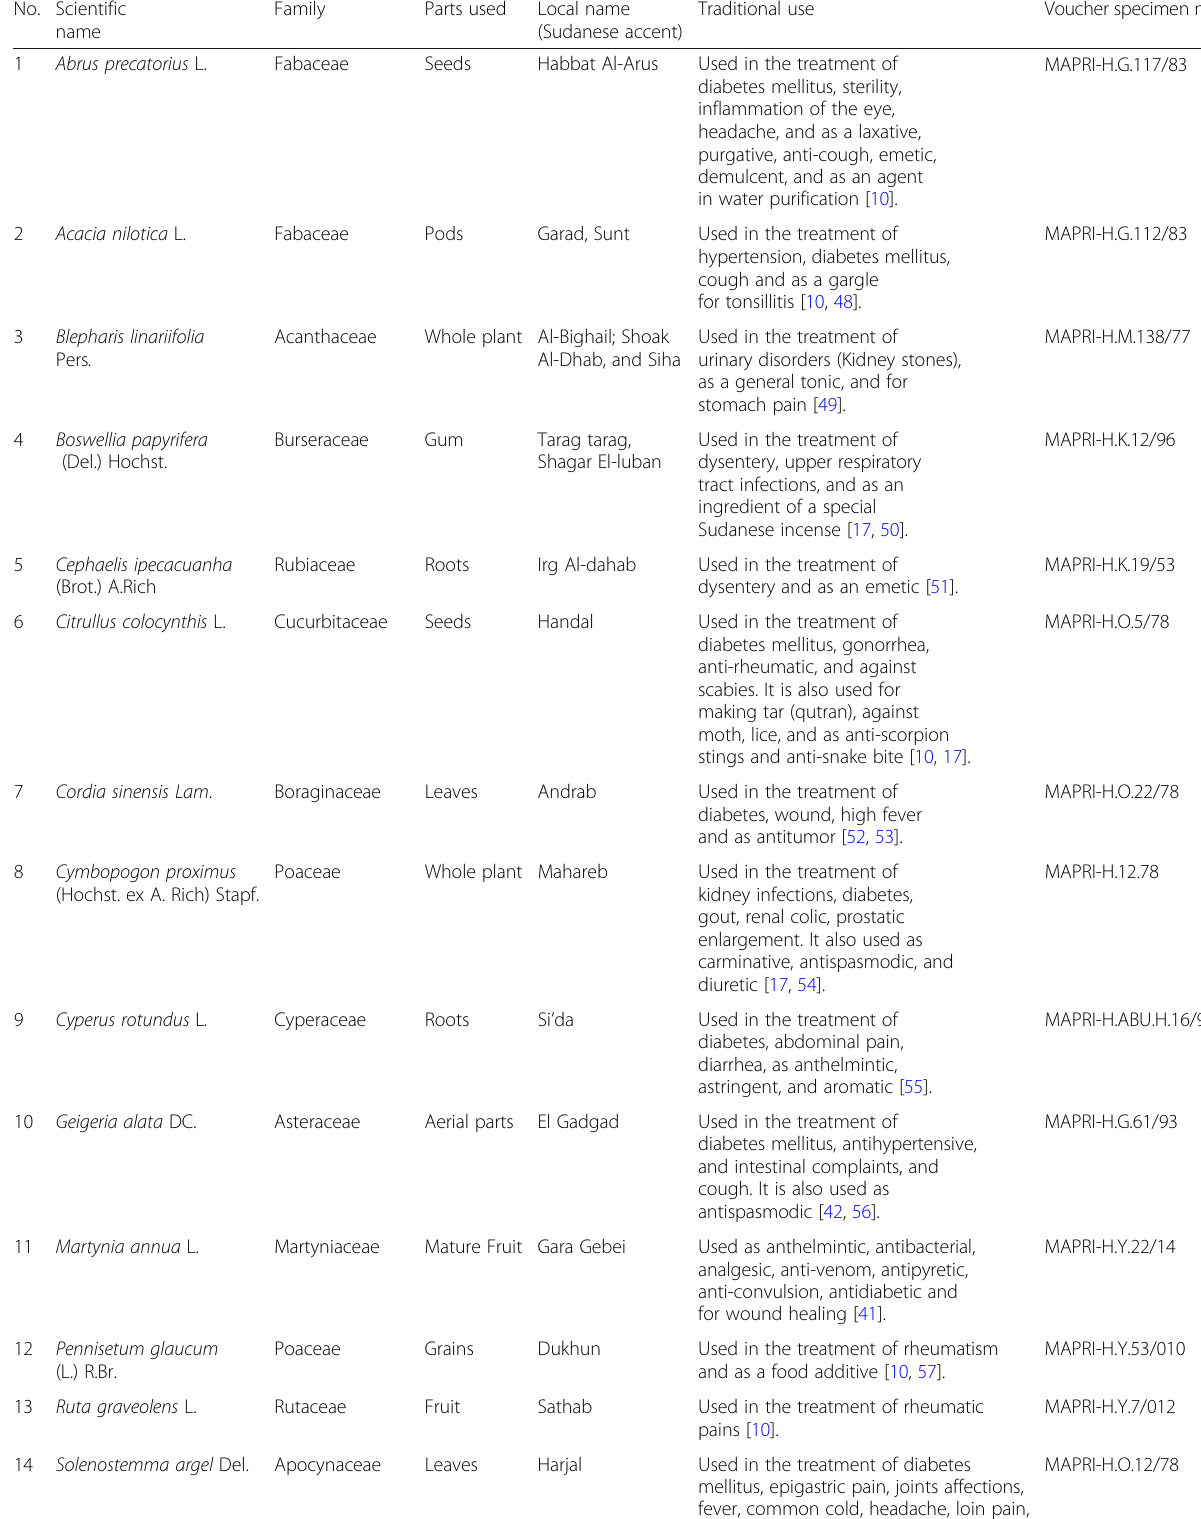
Table 1 Scientific name, family, parts used, local name, traditional use and voucher specimen number of species under